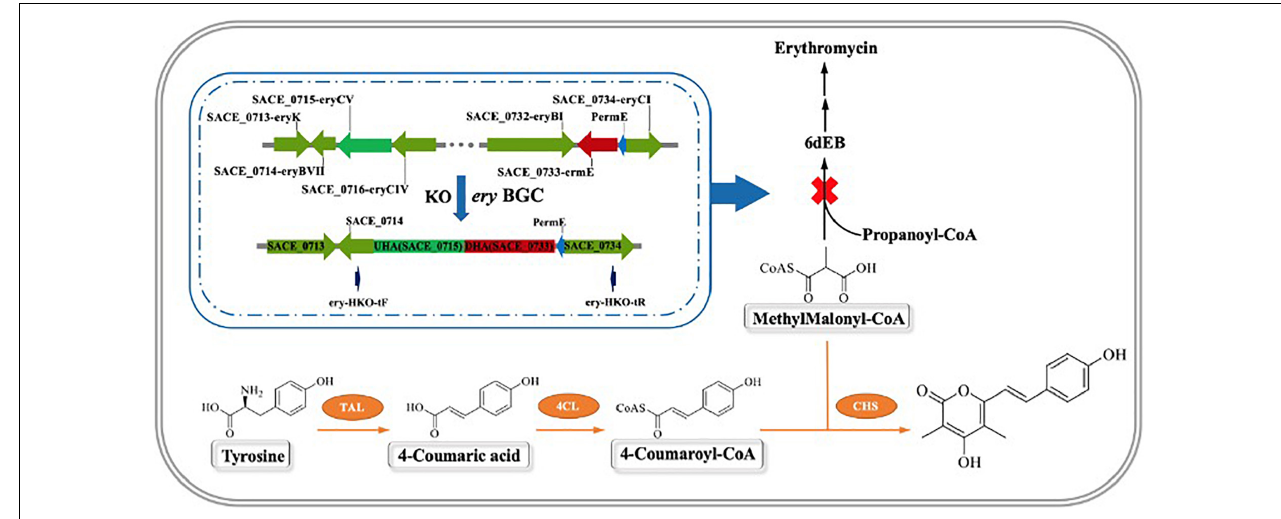
FIGURE 1 | Schematic diagram of the reconstruction of secondary metabolic pathway and the synthesize route of novel metabolites BNY-type